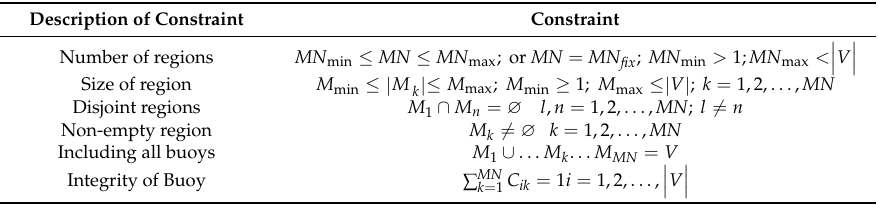
Table 2. Description of